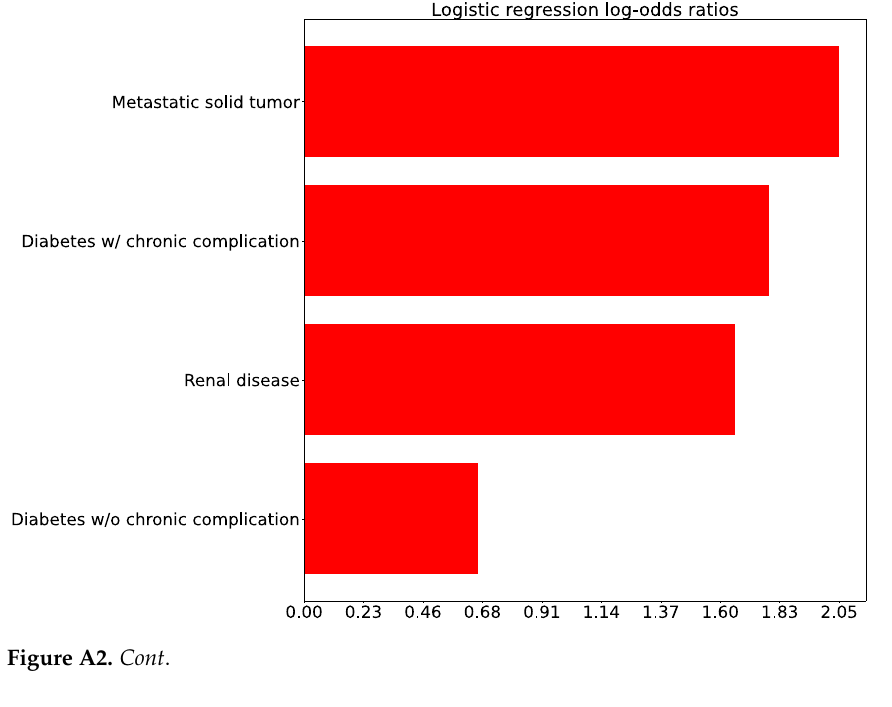
Figure A2. Logistic regression log-odds ratio correlating comorbidities to the outcome for comparison 2: ( a ) Raw log odds ratios and ( b ) Controlled for age. Appendix C Figure A3. Logistic log-odds coefficients correlating comorbidities to the outcome for Comparison 3 (inpatient deterioration), controlling for age.